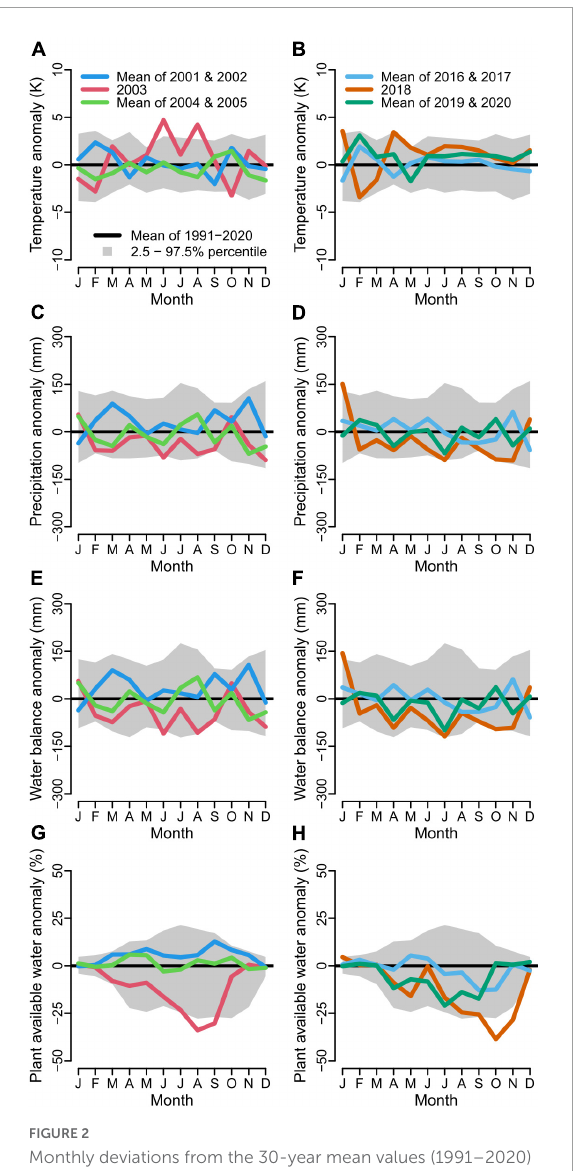
FIGURE2 Monthly deviations from the 30-year mean values (1991–2020) of (A,B) air temperature, (C,D) precipitation sum, (E,F) climatic water balance and (G,H) relative plant available water for the drought years 2003 (left column) and 2018 (right column) together with the mean values of the corresponding two pre-drought and post-drought years. Data were derived for each study site based on a 1 x 1 km grid of the German Meteorological Service (DWD, 2022) and subsequently averaged for the entire elevational gradient. Shaded areas represent the 2.5 and 97.5 % percentiles of annual deviations from the 30-year mean for the baseline climate period 1991-2020.